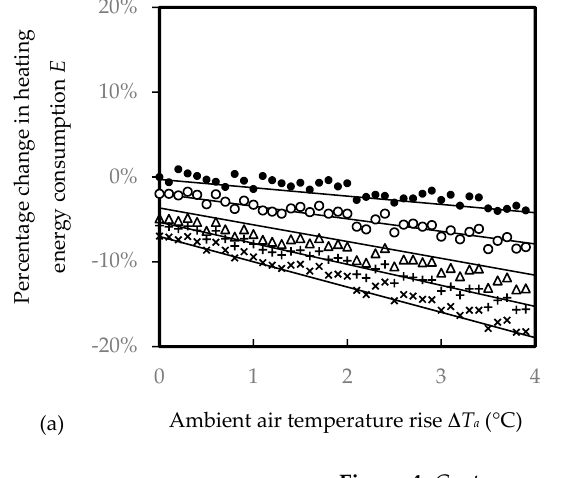
Figure 3. Percentage change in shower water consumption against ambient air temperature rise.